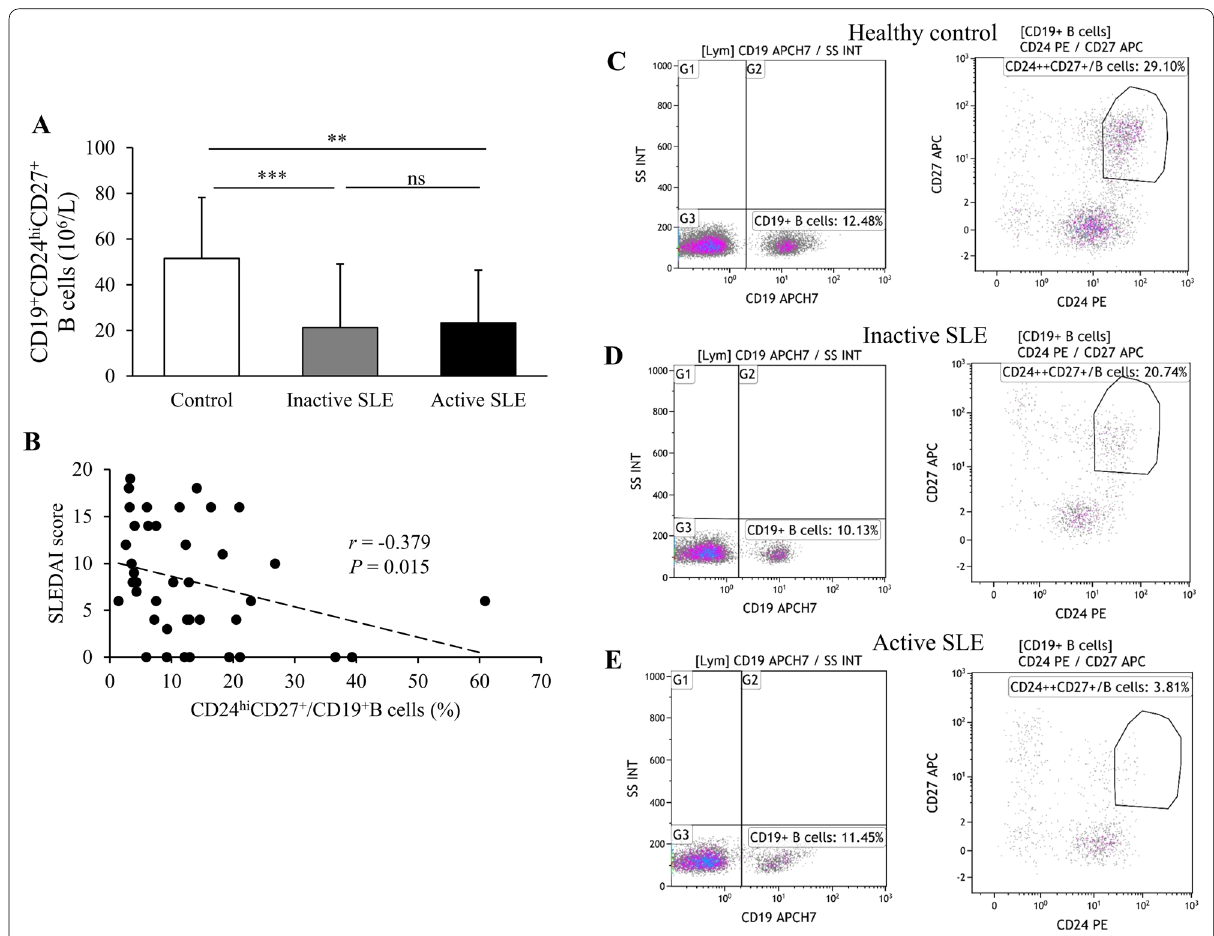
Fig. 2 Association of CD19 + CD24 hi CD27 + B cells with disease activity. A The absolute number of CD19 + CD24 hi CD27 + B cells in the blood samples from healthy controls (n 25), inactive SLE patients (SLEDAI score 4, n 14) and active SLE patients (SLEDAI score > 4, n = ≤ = proportion of CD19 + CD24 hi CD27 + B cells with the SLEDAI score. C – E Representative cases of a healthy control ( C ), an inactive SLE patient ( D ) and an active SLE patient ( E ). ** P < 0.01, *** P < 0.001; ns, not